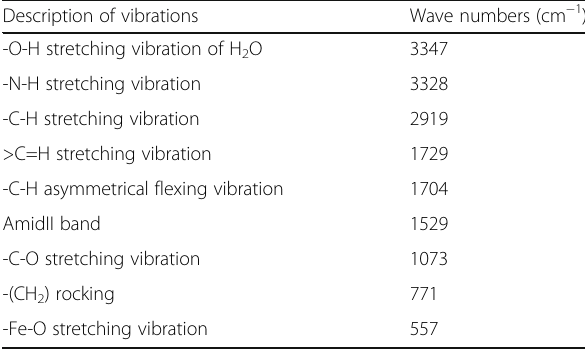
Table 1 Major mid-IR vibrational modes and the corresponding wave